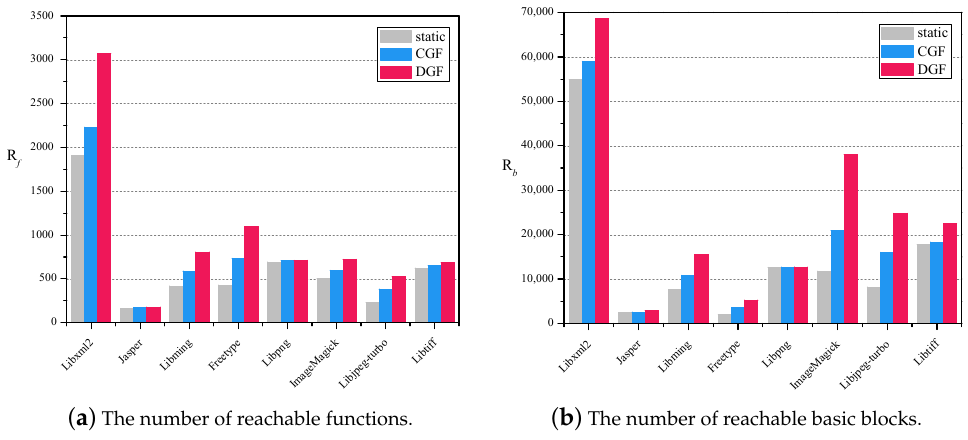
Figure 11. The reachable code scale of CFGs constructed by static-based, CFG-based, and DGF- based